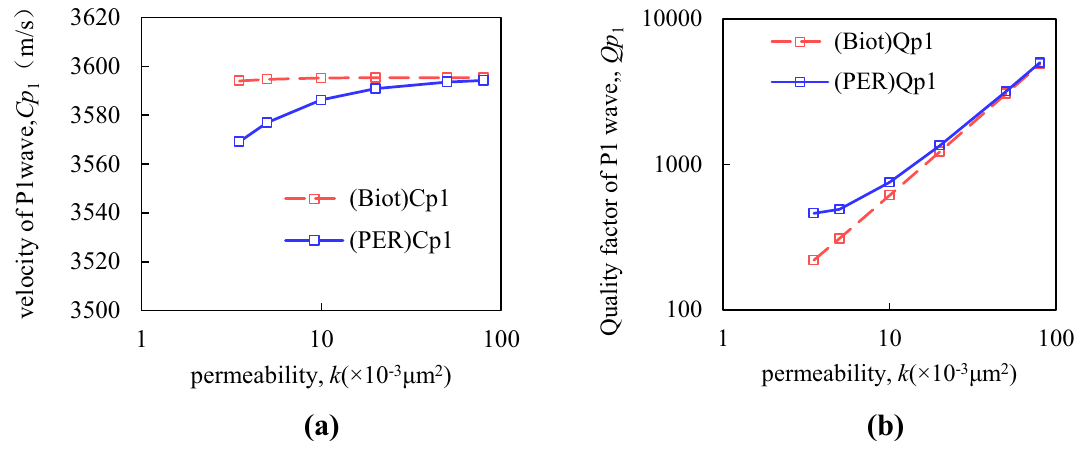
Fig. 3 Velocity and attenuation factor under different permeability (Biot represents Biot’s model, PER represents the improved model with the initial percolation under the pressure gradient, and P1 represent the fast longitudinal wave)